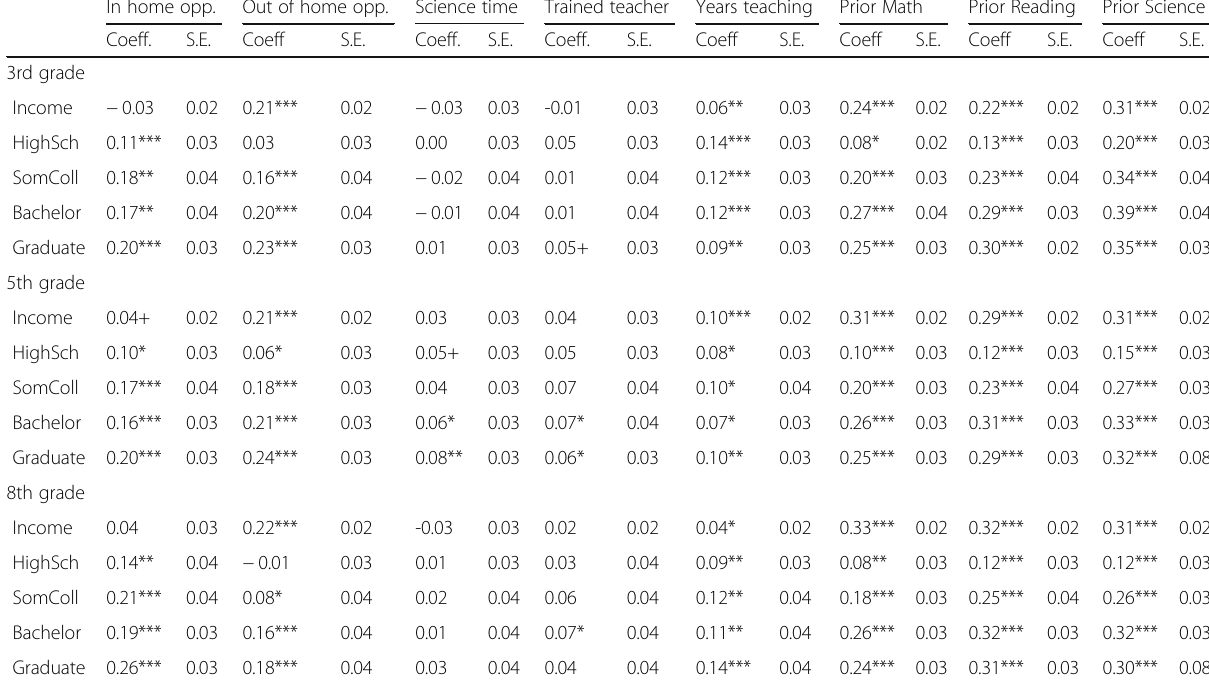
Table 5 Mediation of science inputs between SES and science achievement (from model 5) In home opp. Out of home